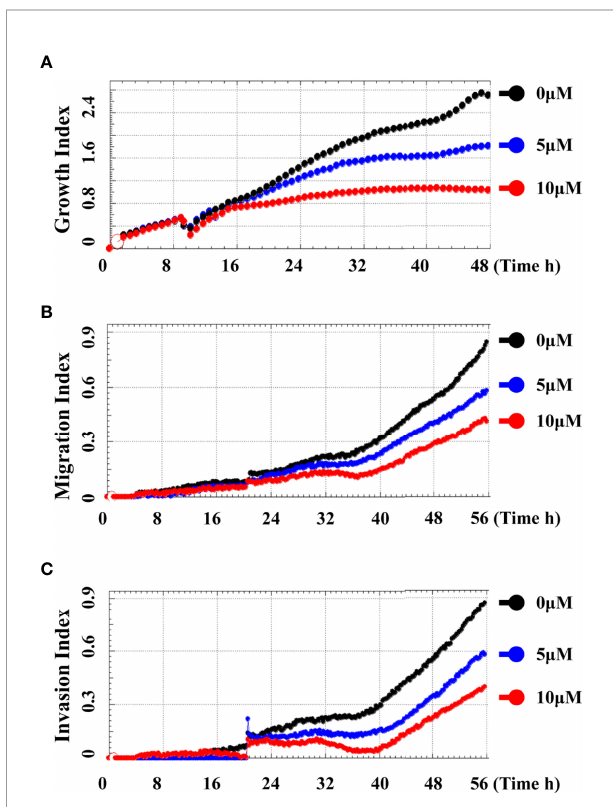
FIGURE 2 | Cordycepin inhibits cell growth, migration, and invasion in TNBC. Cells were analyzed by real time cell analyzer after treating with different concentrations of CD. CD dose dependently inhibited the growth (A) , migration (B) , and invasive (C) in 4T1 cells.